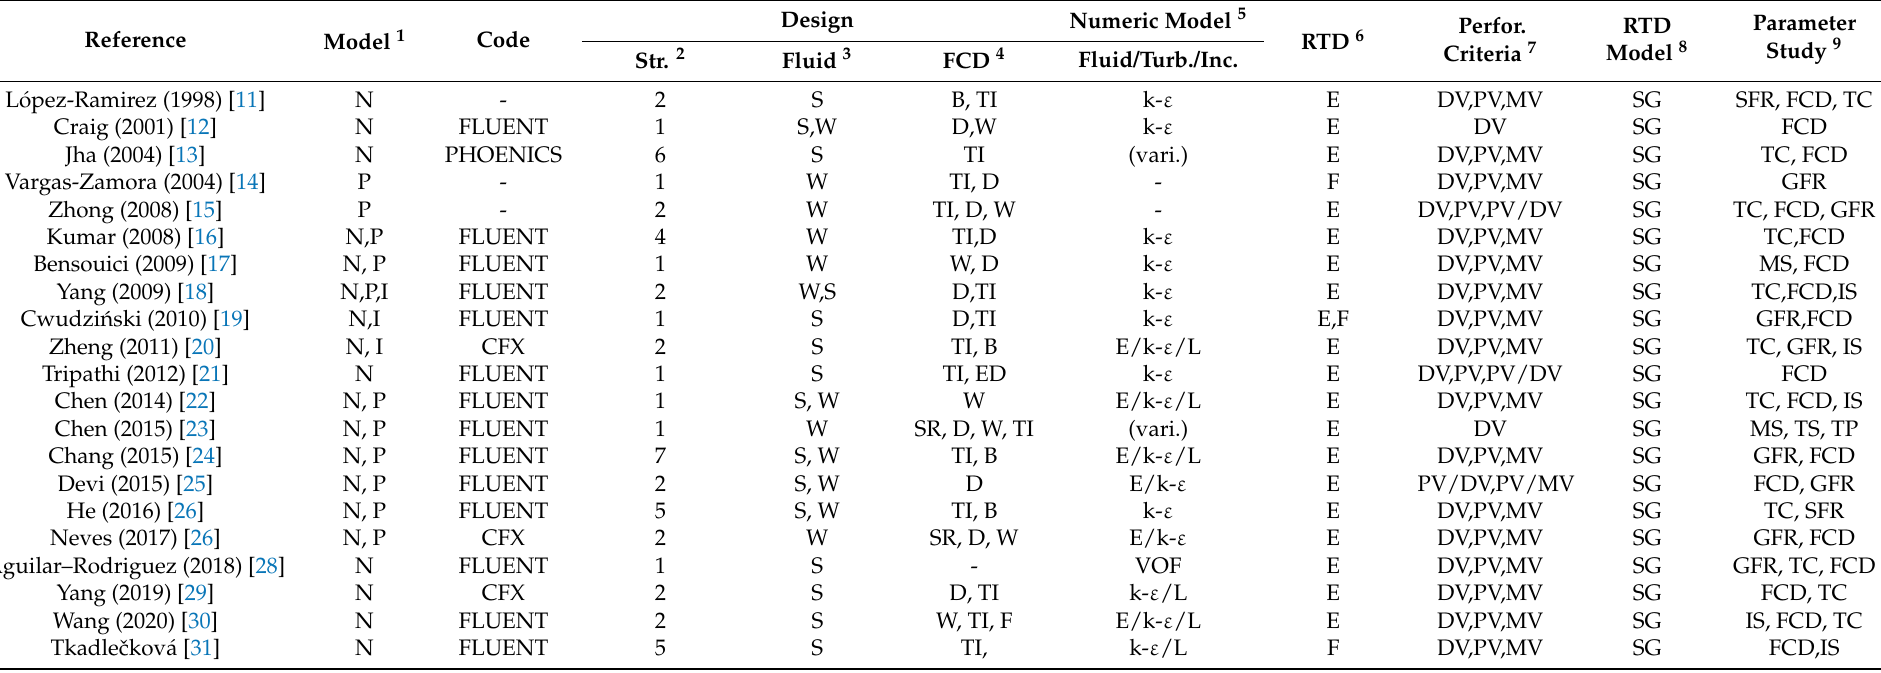
Table 1. Summary of modeling investigations on residence-time distribution (RTD) in the